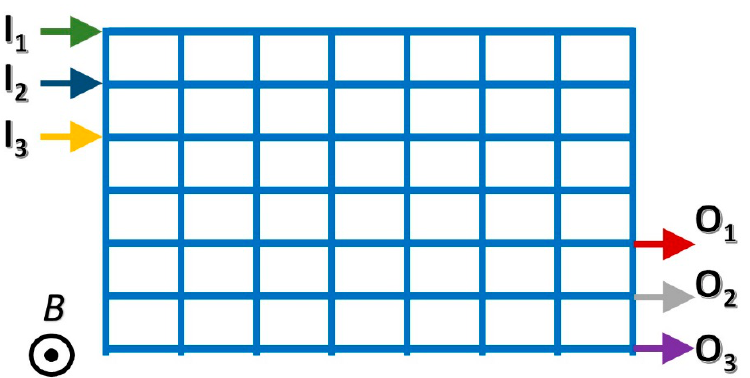
Figure 3. A schematic depiction of a MHD network. Each branch of the network comprises a conduit equipped with a pair of individually controlled electrodes (like in Figure 1A). The network may accept samples and reagents through multiple inlets (I k ) and discharge reaction products via outlets (O k ). By judicious control of individual network branches’ electrical potentials, one can drive fluid flow in the network along any desired path between inlets and outlets; circulate fluids along closed internal paths to expose the fluid to various incubation temperatures; and mix and react various flow streams [34].